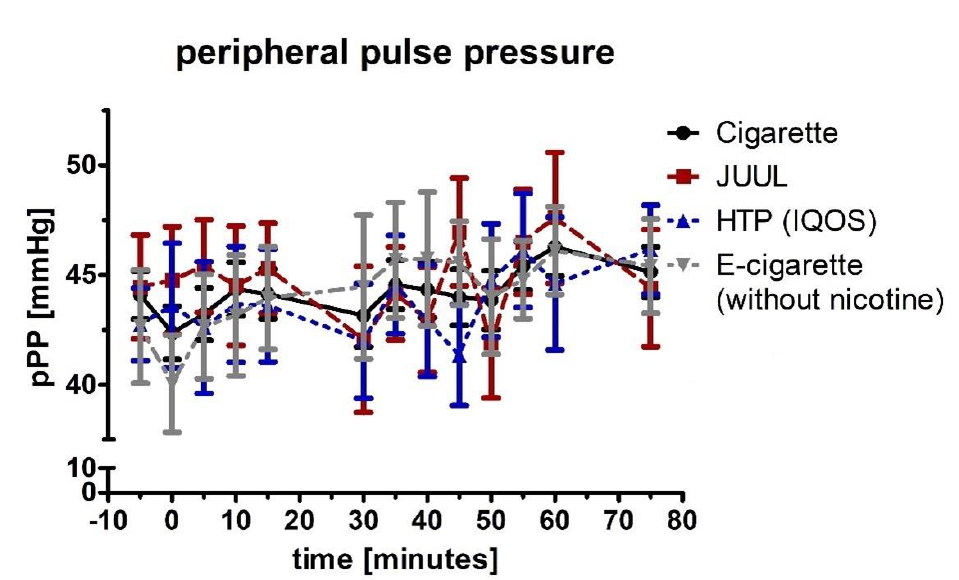
Figure 5. Peripheral pulse pressure in a frequency of 5 min until 75 min after consuming the cigarette, JUUL TM , heated tobacco product and e-cigarette without nicotine. There were no changes reaching significance after the use of any of the